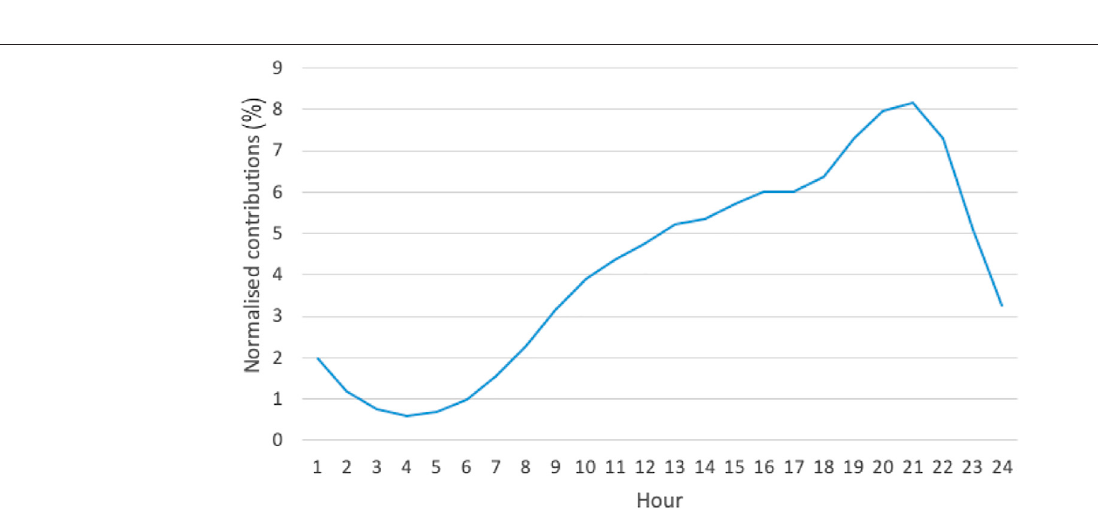
FIGURE 4 | Circadian rhythms of contributions from 20 countries to the Zooniverse.